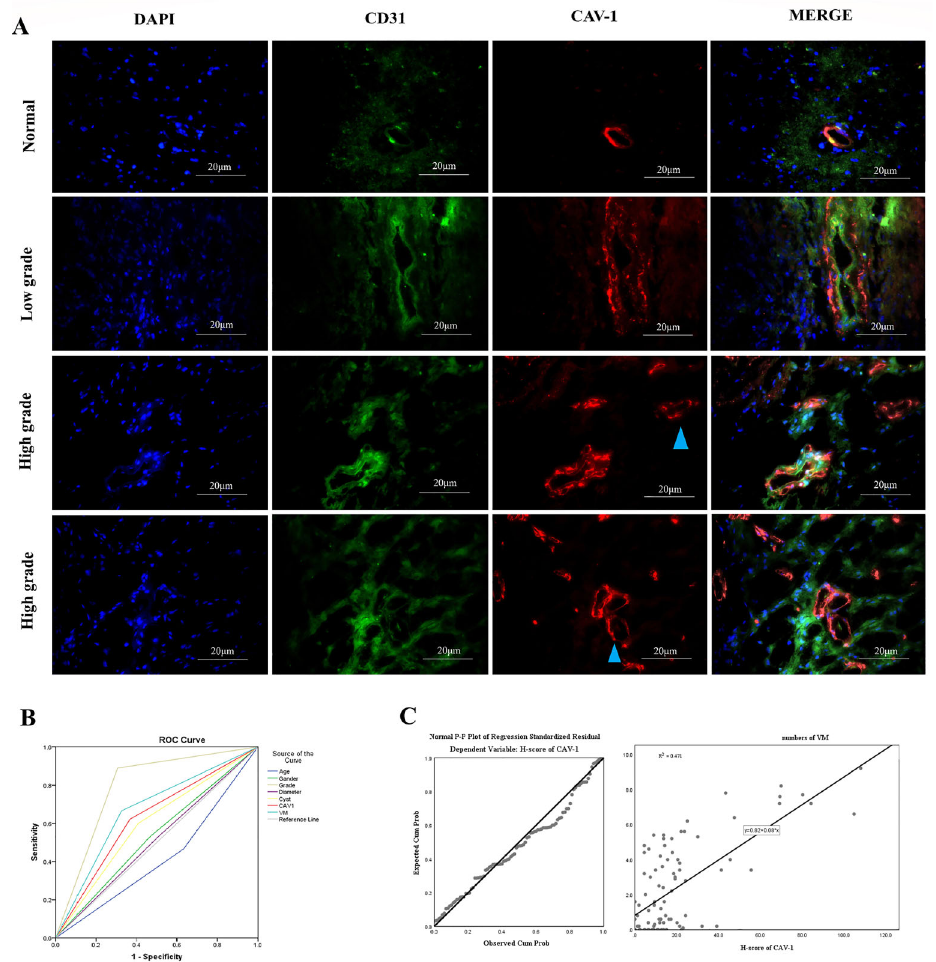
Figure 2. Immunolocalization and correlation between vasculogenic mimicry (VM) formation and Cav-1 expression in glioma (n=94). A , Cav-1 (red) and CD31 (green) expression in the blood vessels of normal tissues and low-grade gliomas and abundant Cav-1-positive (red) and CD31-negative cells around the VM-like structures (blue arrow heads) in high-grade glioma tissues (scale bar 20 m m). B , ROC analysis shows cause-effect relationship between factors and survival. Diagonal segments are produced by ties. C , Correlation between VM formation and Cav-1